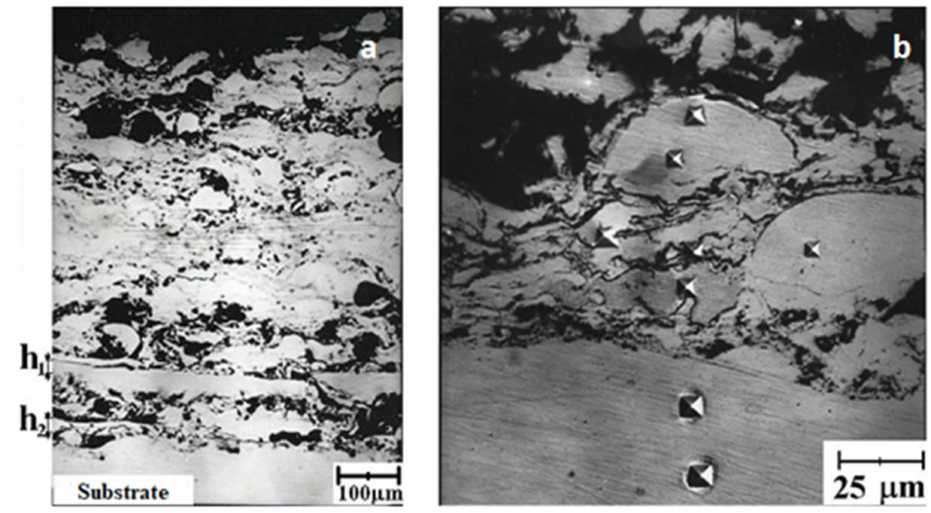
Figure 7. Optical images of transverse thin sections: ( a ) with non-etched white stripes along the “coating–substrate” interface and ( b ) with fused powder